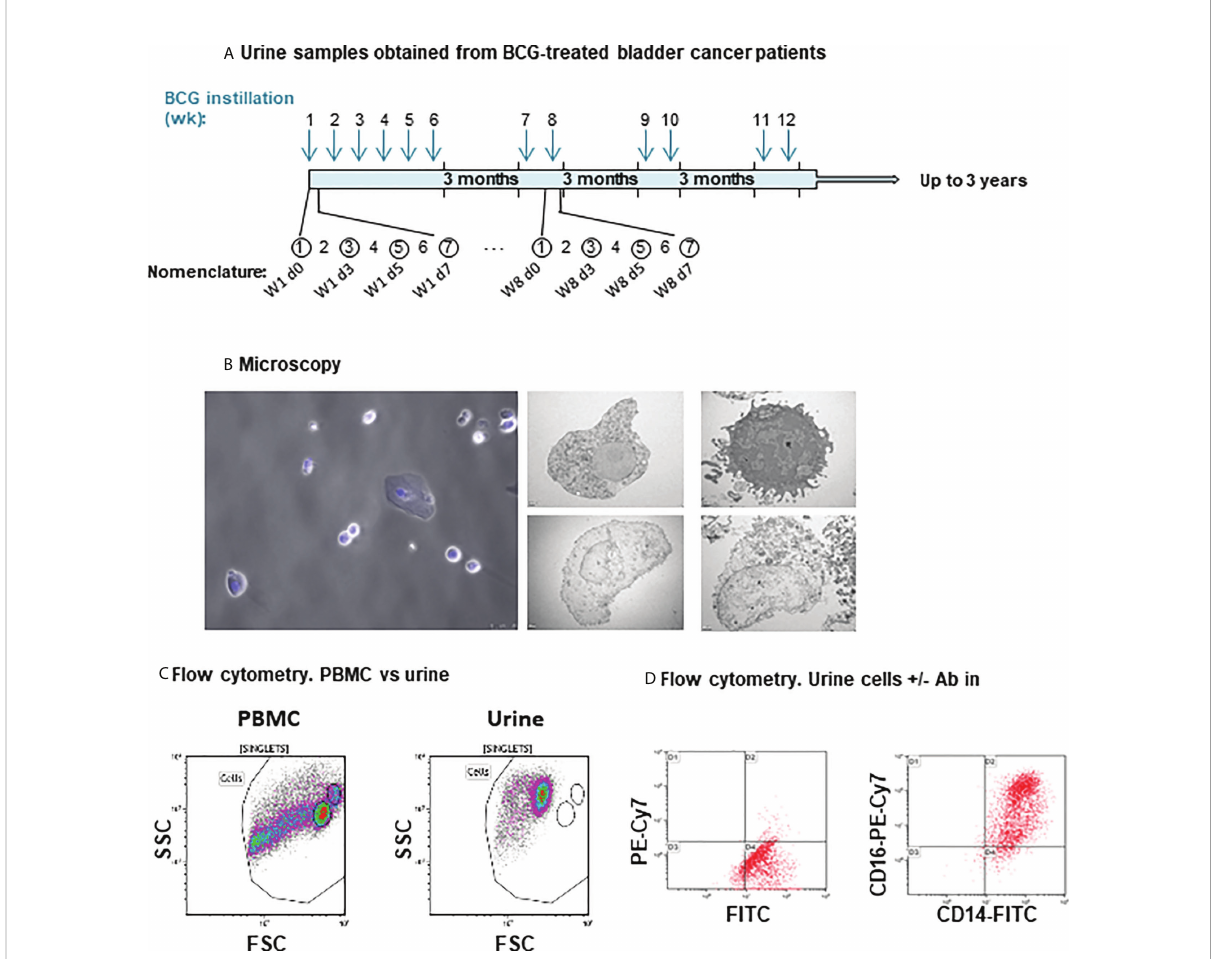
FIGURE 1 Cells recruited to urine analysed by microscopy and fl ow cytometry. (A) Schematic representation of the BCG treatment time line and urine samples obtained from bladder cancer patients. During the fi rst cycle, patients received one weekly instillation for 6 weeks. After a three-month rest, they received a second cycle of two weekly instillations and this treatment continued up to three years. Arrows indicate the time (weeks) of the instillation calendar and circles an example of sample collection. The nomenclature used refers to the instillation week and the number